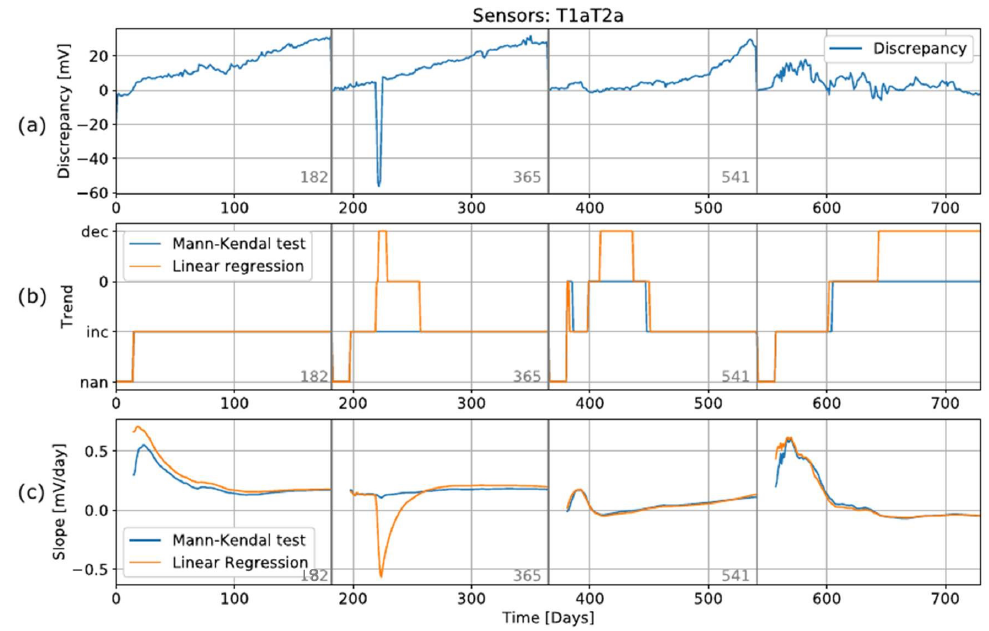
Figure 10. Iterative process of trend detection with raw dataset. The graphs show ( a ) raw data, ( b ) trend detection, and ( c ) slope calculated by trend detection